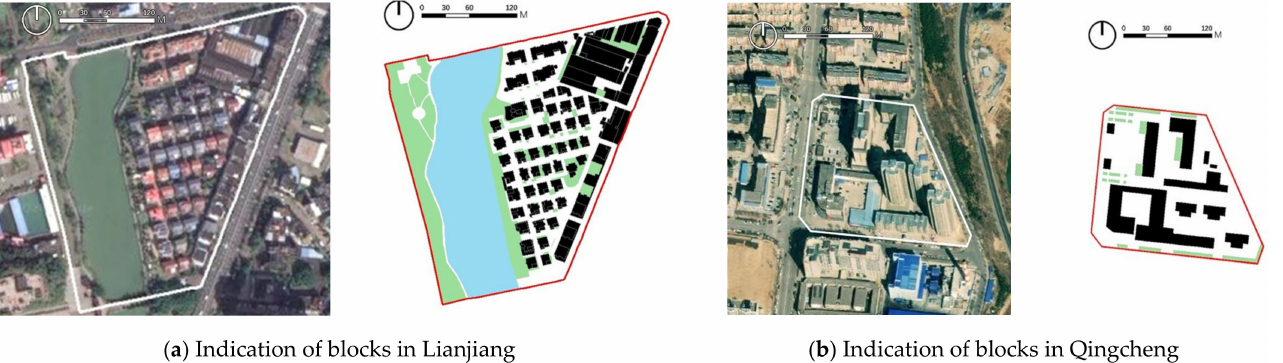
Figure 9. Typical blocks in different